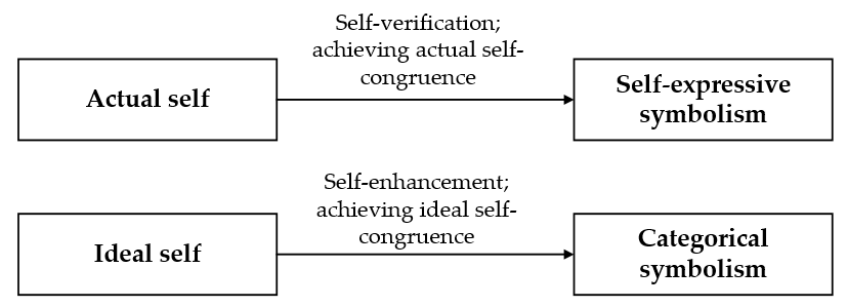
Figure 2. Working mechanism of self-expressive and categorical symbolism.